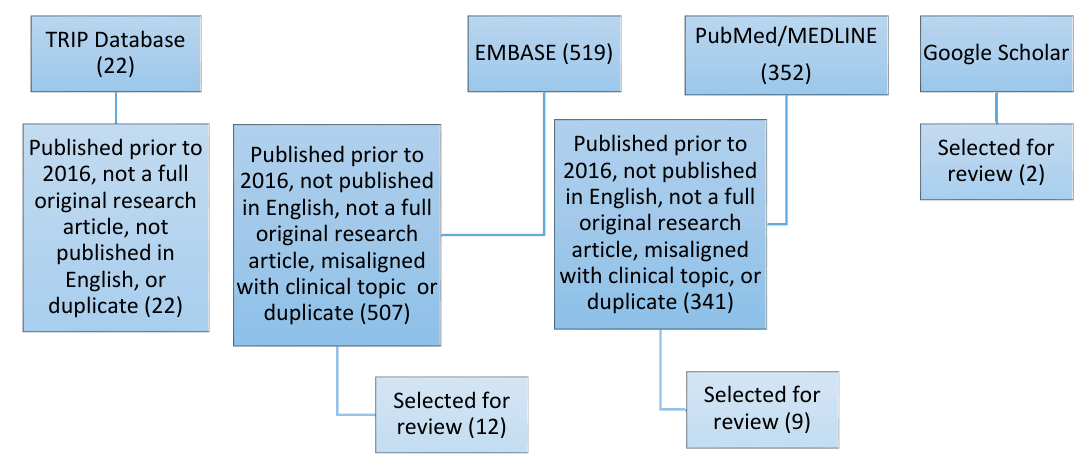
Figure 1. Literature Search Strategy and Results.